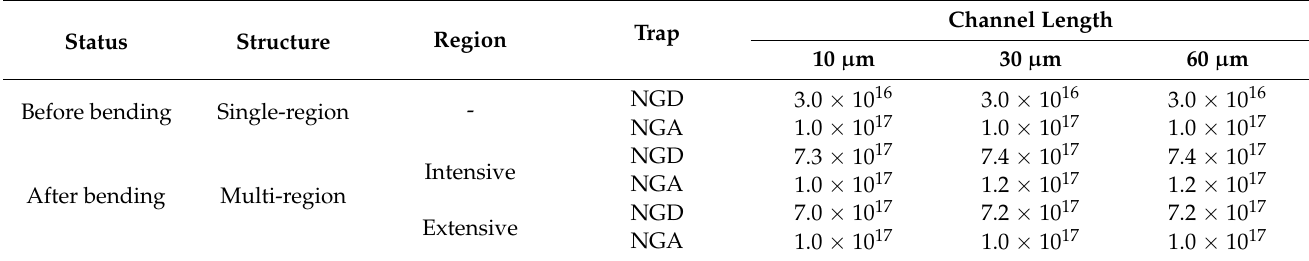
Table 3. Density of states of the parameters of the a-IGZO layer for fitting the measurements before and after parallel bending using the single- and multi-region structures,